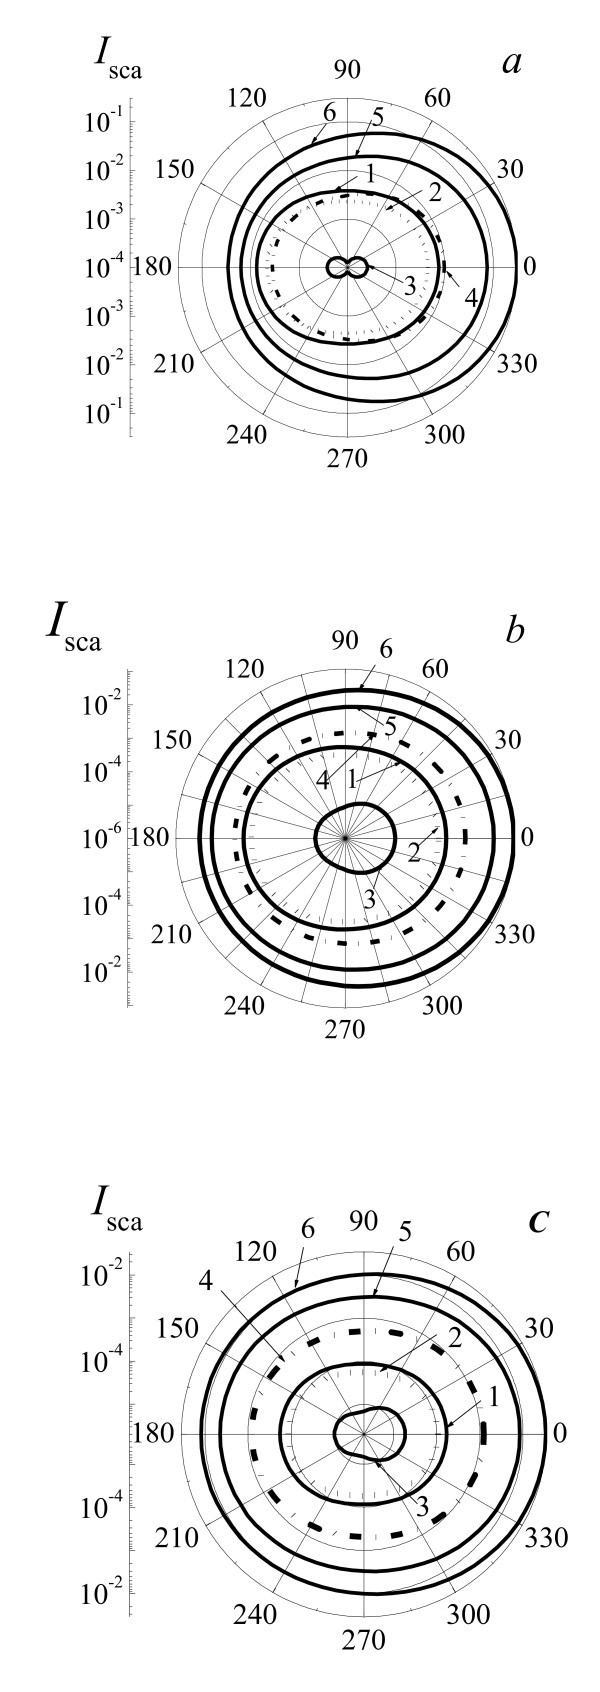
Angular distributions (optical indicatrixes) of radiation intensity Isca. With wavelength 532 nm (a), 633 nm (b), and 780 (c) nm scattered by two-layered spherical system gold NP core and water vapor shell placed in water for the NP radius r0 = 20 nm and radii of system r1 = r0 (1, pure gold NP, straight line), r1 = r0 + 0.1r0 (2, dotted line), r1 = r0 + 1r0 (3, straight line), r1 = r0 + 2r0 (4, dashed-dotted line), r1 = r0 + 3r0 (5, straight line), r1 = r0 + 4r0 (6, straight line). Direction of laser radiation propagation is from left to right (from 180° to 0°). Polar coordinates show angles for scattered radiation in the range 0° to 360°; scale Isca shows arbitrary units of intensity.